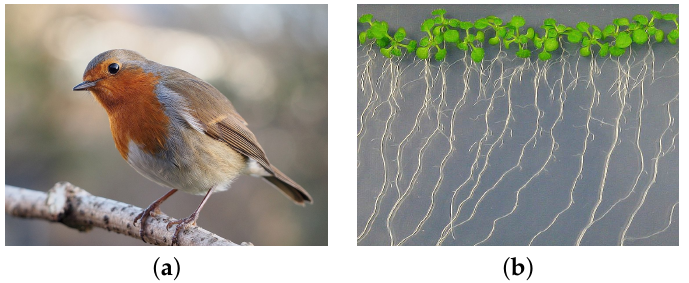
Figure 2. ( a ) European robin Erithacus rubecula , which is assumed to use a quantum magnetochemical compass for orientation and navigation in the geoMF during seasonal flights up to 2000 km [17,26]. Photo ©2014 by F.C. Franklin/CC-BY-SA-3.0. ( b ) Sprouts of the thale cress Arabidopsis thaliana that respond to a weak MF do not have special magnetic receptors (e.g., [27]). Photo ©2014 by Alena